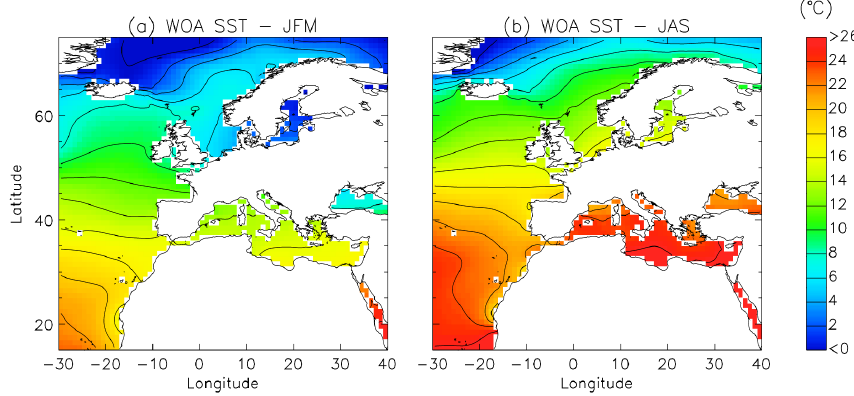
Fig. 2. Climatological sea surface temperature of the northeast Atlantic in (a) winter (January, February, March) and (b) summer (July, August, September) from WOA05 (Levitus, 2006).